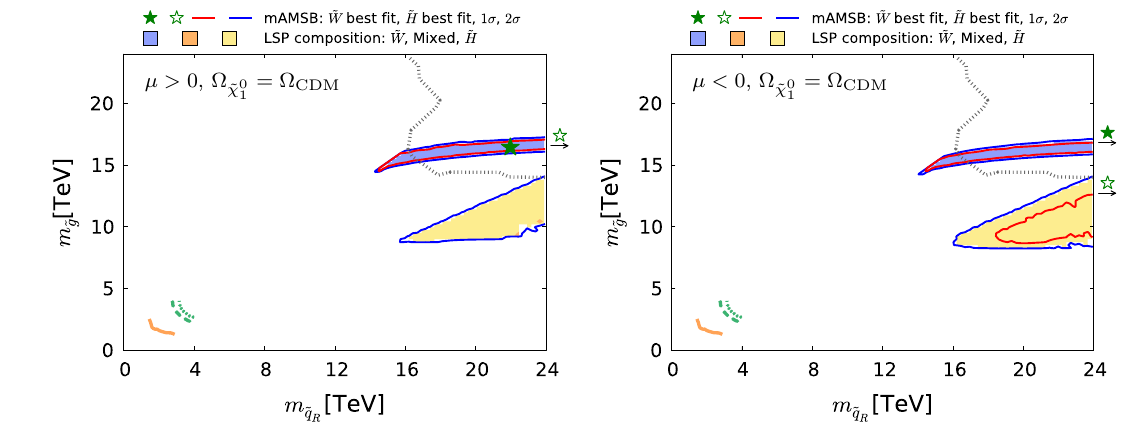
, m ˜ ) plane allowed in the (cid:4) = 14-TeV data with 300 and 3000 f b − 1 , respectively. The grey dotted Fig. 25 The region of the ( m ˜ q ˜ χ 0 g R 1 μ > 0 ( left ) and μ < 0 ( right ). The orange solid line (cid:4) line is the 95% CL sensitivity expected at a 100 TeV pp collider with CDM case for a 3000 f b − 1 integrated luminosity obtained from [142]. All contours represents the LHC 8-TeV 95% CL exclusion [138]. The green dashed assume massless ˜ χ 0 . The shadings are the same as in Fig. 4 and dotted lines show the projection estimated by ATLAS [140] for 1